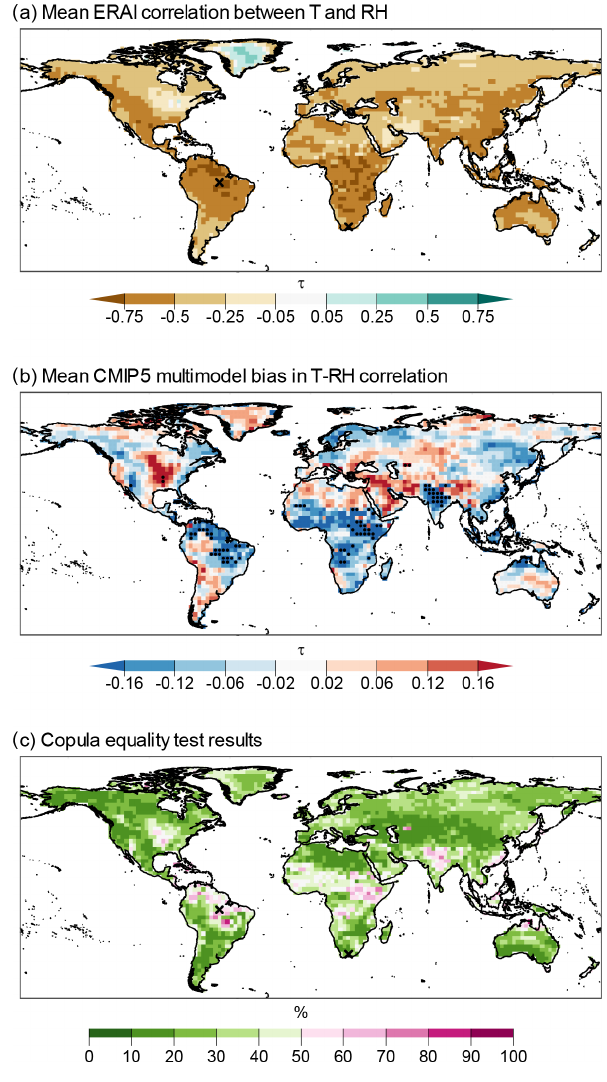
Figure 4. Mean ERA-Interim correlation ( τ ) between T and RH (a) , mean CMIP5 multimodel bias in τ (b) , and the proportion of CMIP5 samples where the copula equality was rejected (c) . Stip- pling in panel (b) indicates locations where the correlations of more than 75% of CMIP5 model samples have significantly different values compared to ERA-Interim, as calculated using Bonferroni- corrected p values. Bias was calculated as (CMIP5 minus ERA-